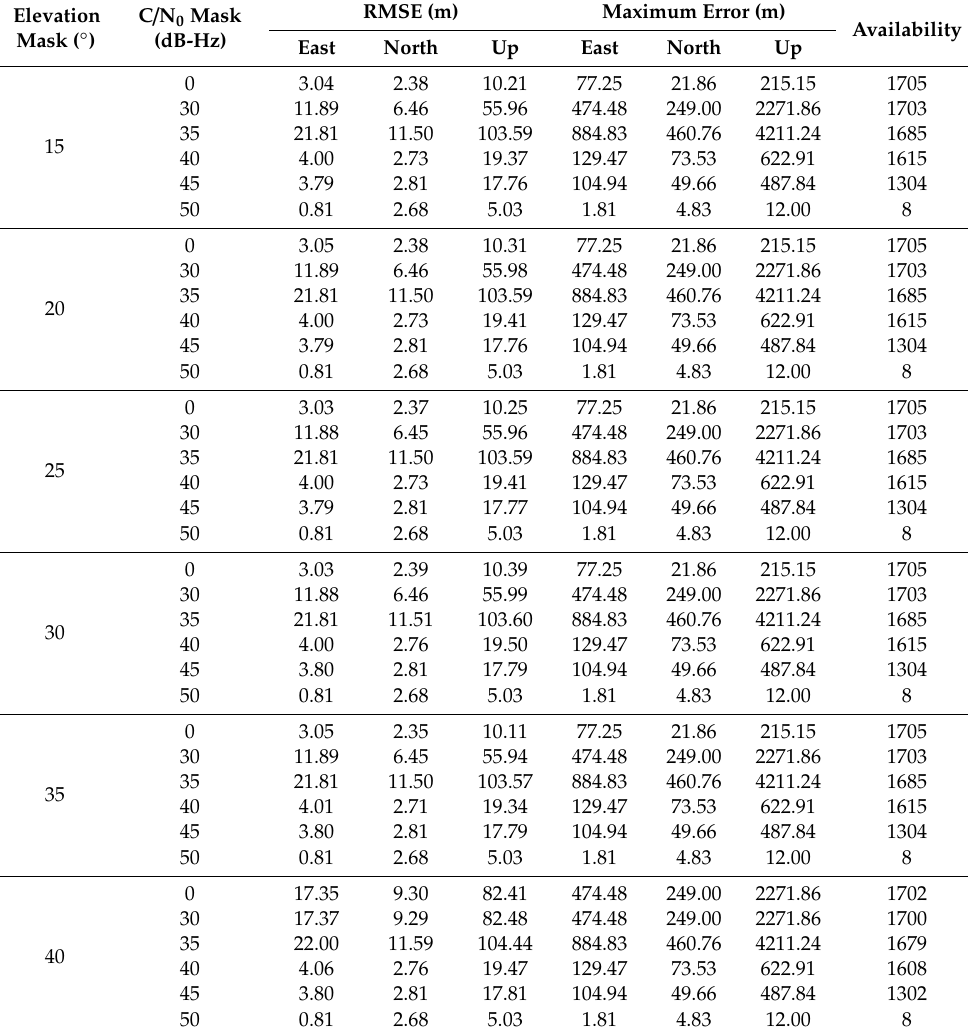
Table 4. Positioning results of D1a corresponding to di ff erent elevation angle masks and C / N 0 masks. Elevation Mask ( ◦